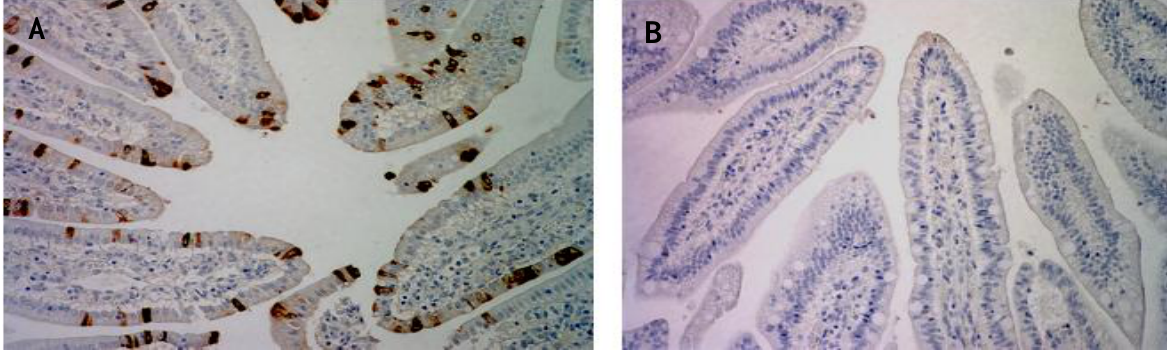
Figure 9. Effect of SLPE feeding on immunohistochemical detection of rotavirus in intestinal tissue from rotavirus-infected piglets. Piglets were inoculated with rotavirus (1 × 10 5 FFU) in the presence of MEM or SLPE (2 µmol) and fed MEM or SLPE (2 µmol) every 12 h, euthanized 28–96 h post-inoculation, and intestinal tissue harvested and processed for immunohistochemical detection of rotavirus antigen as described in the Experimental Section. Typical photomicrographs of immunohistochemically stained sections of small intestinal segments from control and SLPE-fed, virus-infected piglets are shown below. ( A ) rotavirus-inoculated pig fed MEM (40 h); ( B ) rotavirus-inoculated pig fed SLPE (40